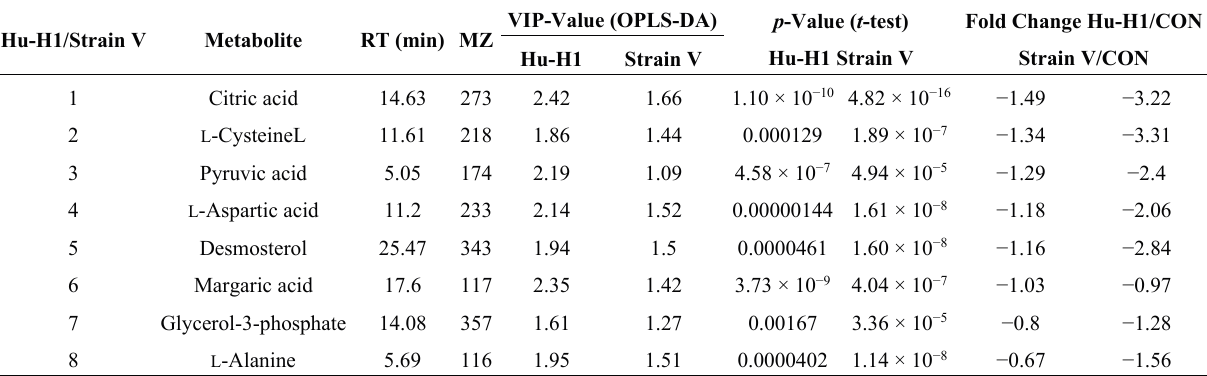
Table 3. Key commonly altered metabolites detected by GC–MS for Hu-H1 and Strain